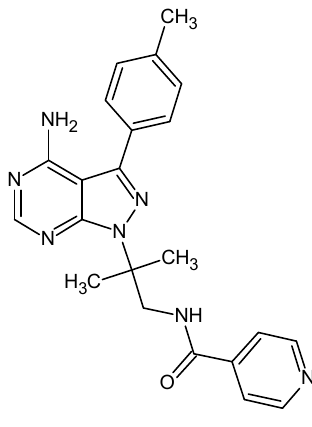
Figure 1. 2D chemical structure of compound WEHI-345.